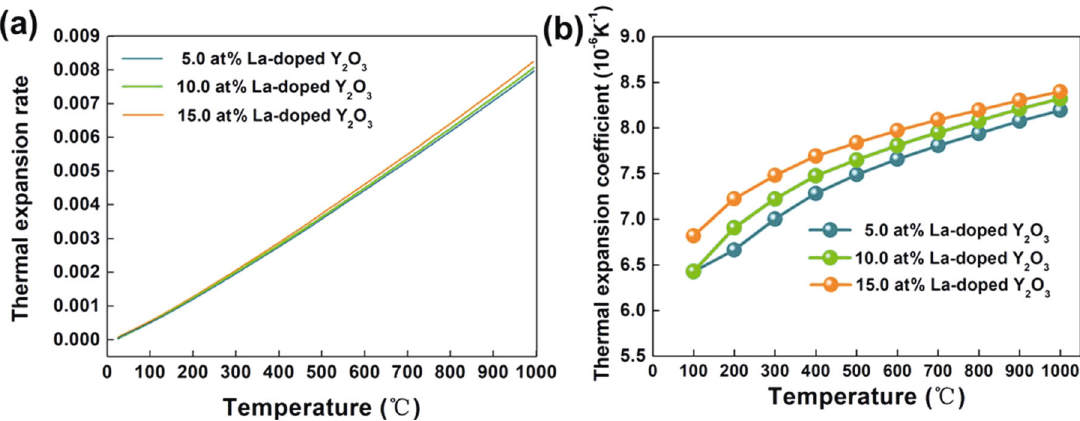
Fig. 5 (a) Thermal expansion ration and (b) thermal expansion coefficient of La-doped Y 2 O 3 ceramics dependence on